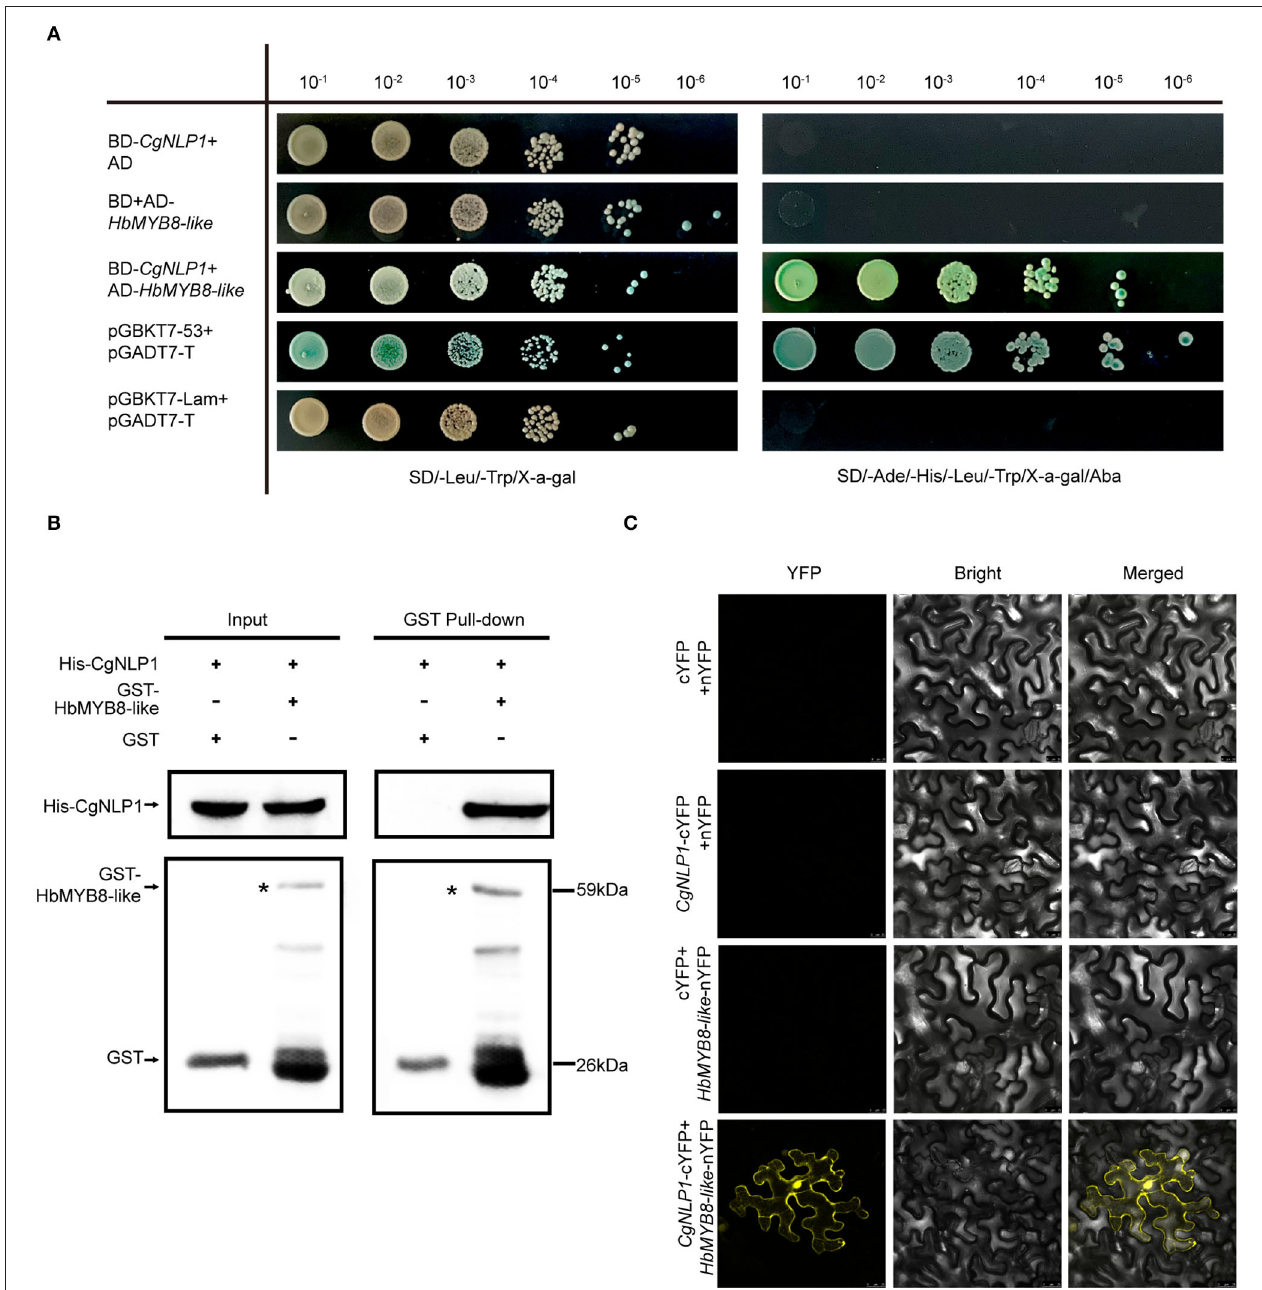
FIGURE 5 | Screening and verification of the interaction between CgNLP1 and HbMYB8-like. (A) Verification of the interaction between CgNLP1 and HbMYB8-like by yeast two-hybrid assay. AD indicates pGADT7, BD indicates pGBKT7, pGADT7-T + pGBKT7-53 indicates a positive control, and pGBKT7-Lam + pGADT7-T indicates a negative control. SD/-Leu/-Trp/X- α -gal indicates the medium with X- α -gal, but lacking Leu and Trp. SD/-Ade/-His/-Leu/-Trp/Xa-gal/Aba indicates the medium with X- α -gal and Aba, but lacking Ade, His, Leu, and Trp. 10 − 1 , 10 − 2 , 10 − 3 , 10 − 4 , 10 − 5 , and 10 − 6 , respectively, refer to the yeast suspension with the initial optical density (OD) value of 2.0 being diluted in a 10-fold gradient. (B) Verification of the interaction between CgNLP1 and HbMYB8-like by GST pull-down assay. His and GST stand for pCold TM TF and pGEX, respectively. Arrows indicate GST- and His-tagged proteins. (C) Verification of the interaction between CgNLP1 and HbMYB8-like by bimolecular fluorescence complementation (BiFC) assay. cYFP + nYFP, CgNLP1 -cYFP + nYFP, and cYFP + HbMYB8-like -nYFP were used as a negative control. Scale bar = 25 µ m.